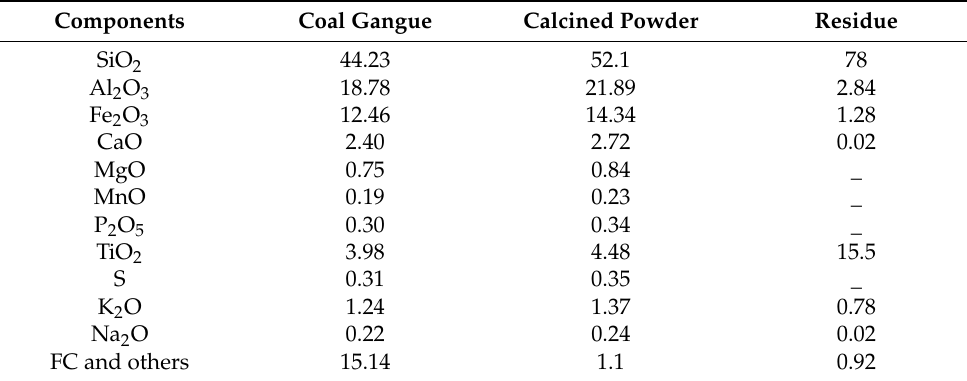
Table 1. Main components of the coal gangue, calcined powder, and residue wt %.